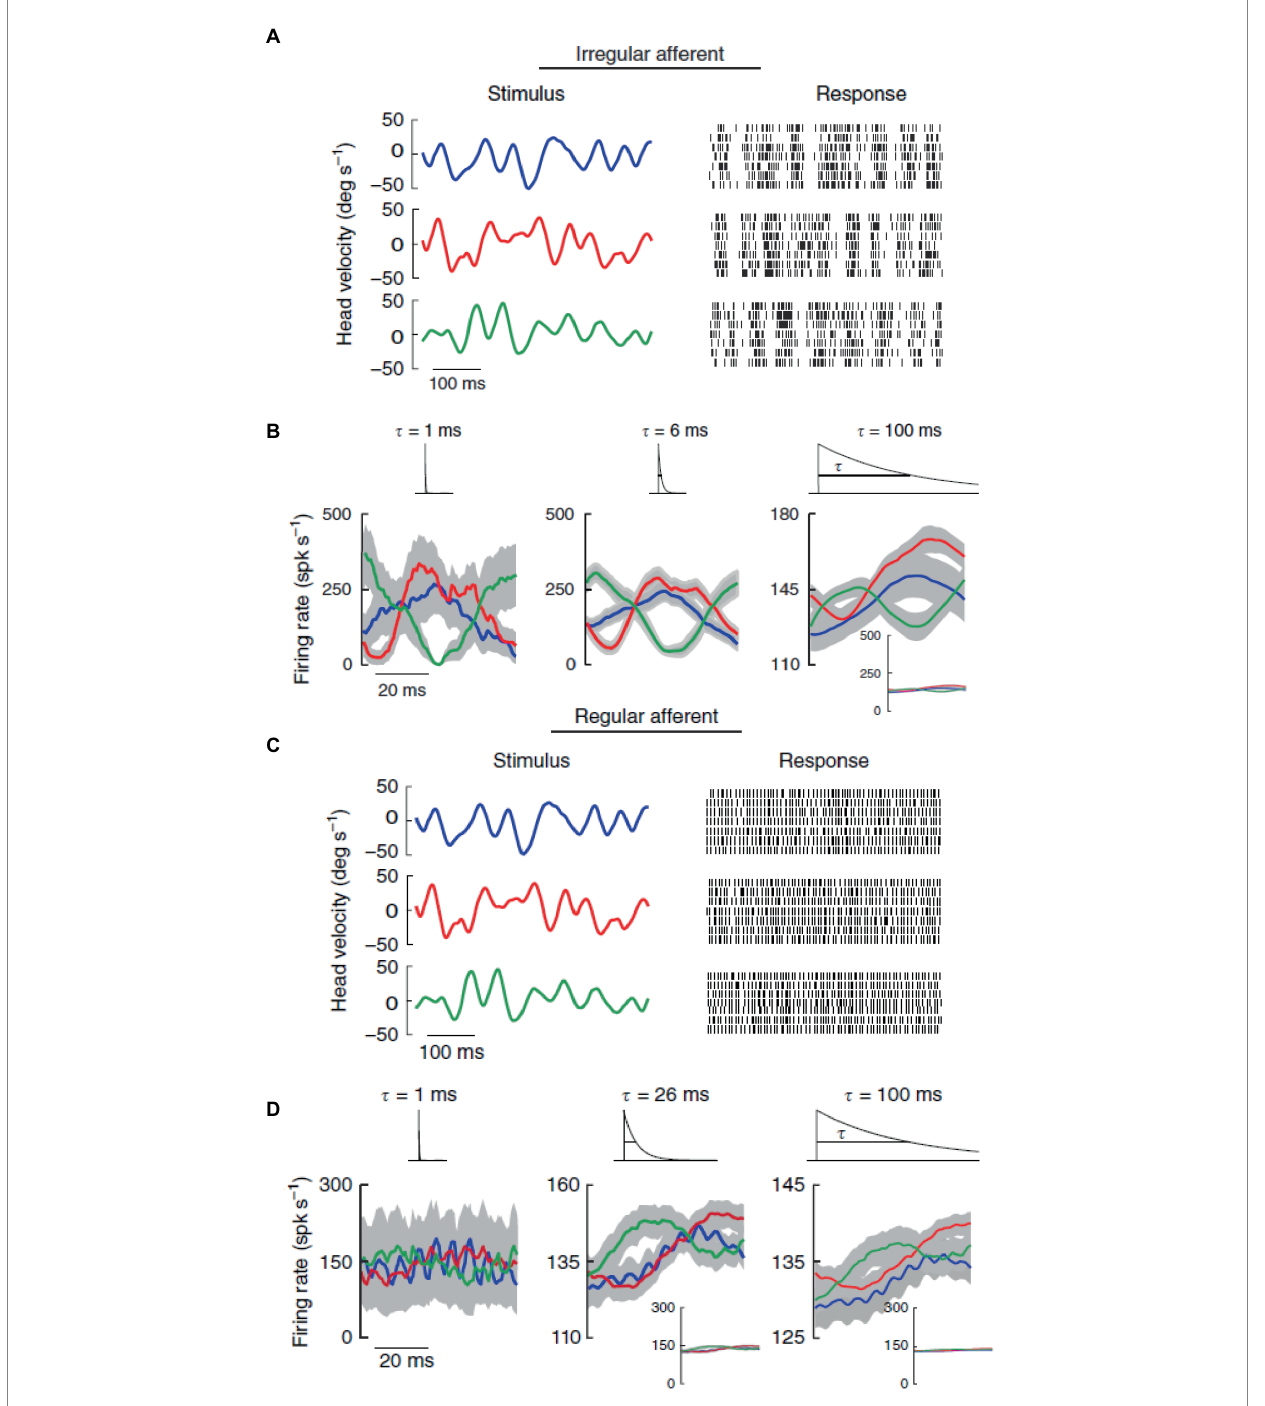
FIGURE 3 In contrast with regular afferents, irregular afferents discriminate between different stimulus waveforms through precise spike timing. (A) Spiking responses from an irregular afferent to repeated presentations of three different stimulus waveforms (broadband noise angular velocity stimulus, 20 Hz cutoff) with identical statistics (mean 0 ° /s, standard deviation 20 ° /s). (B) Average responses (standard error bands as shaded gray) of the irregular afferent to multiple repeated presentations to three different stimulus waveforms (red, blue, green) at 1 ms (left), 6 ms and 100 ms (right) timescales. The responses were obtained by convolving the spike trains with exponential kernels (top insets) that decay with these time constants. (C) Same as in panel (A) but for a regular afferent. (D) Same as in panel (B) but for the regular afferent. Reproduced with permission from Jamali et al.